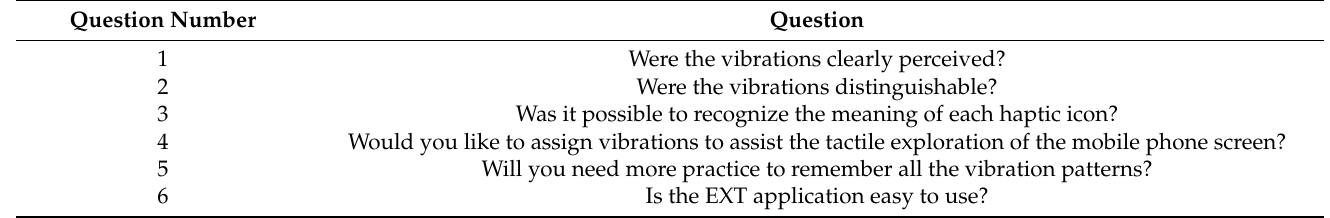
Table 2. Usability form.